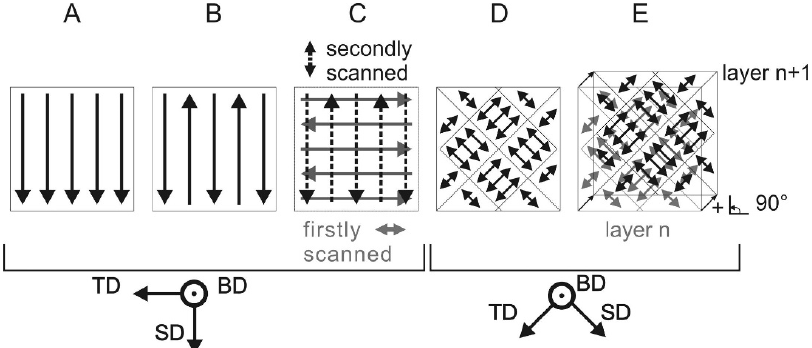
Figure 11. Schematics showing the different types of hatch styles that are employed during the SLM